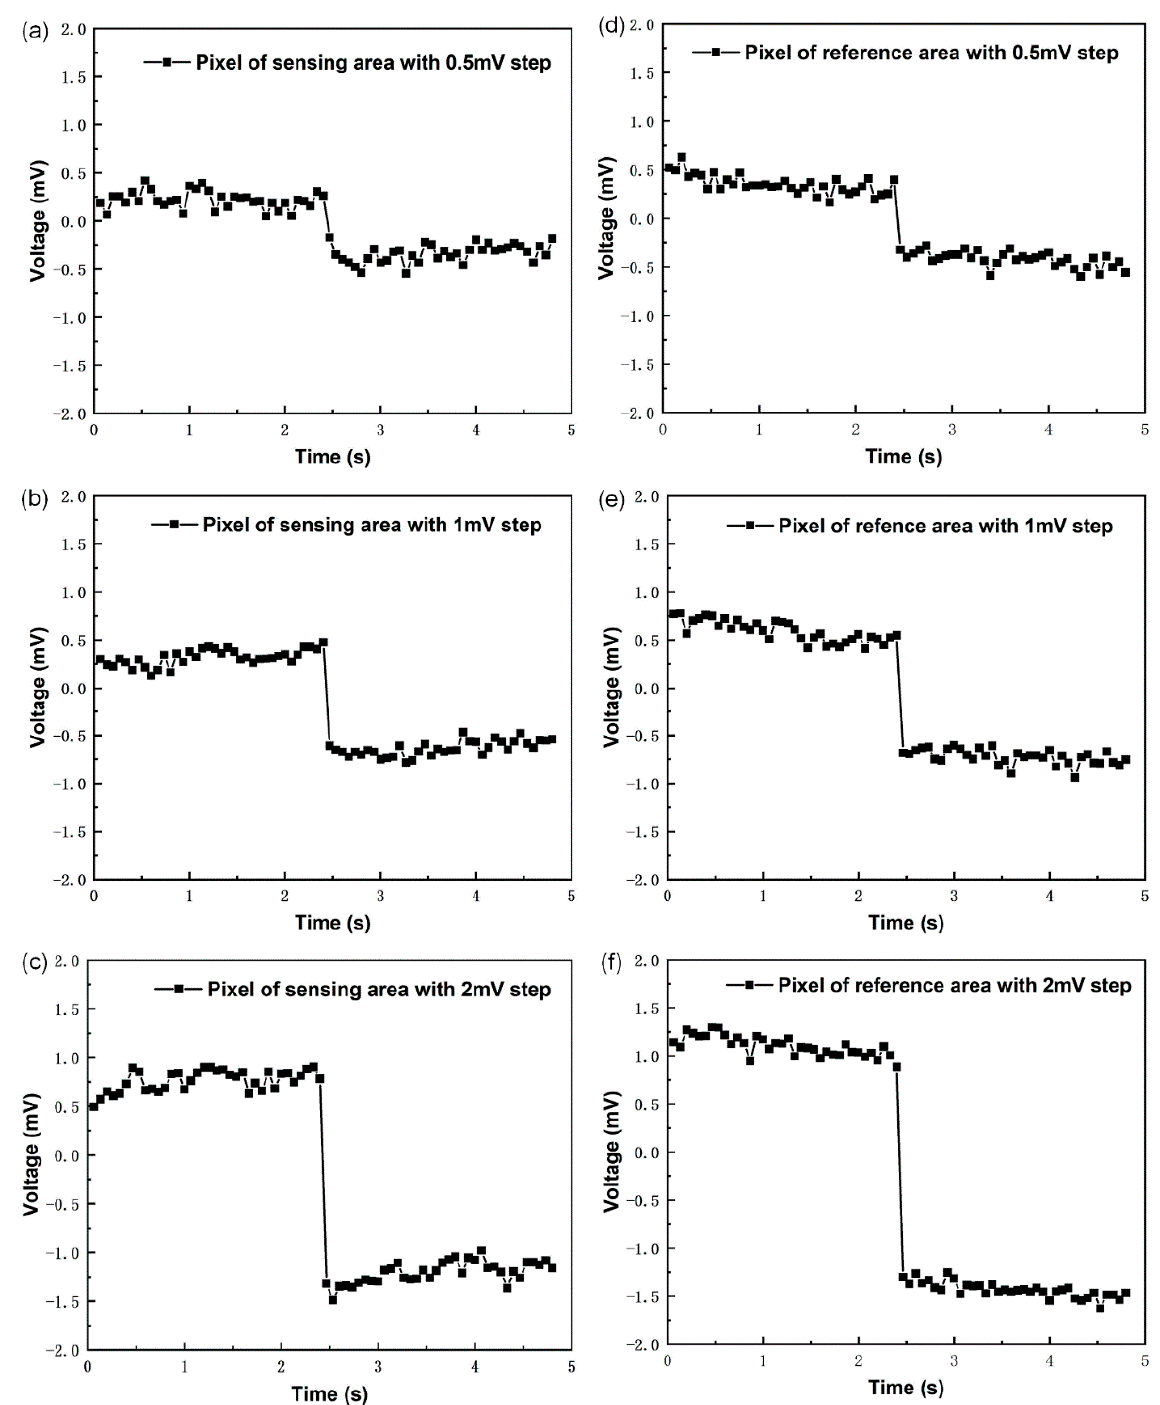
Figure 7. The change in the pixel output voltage with the reference voltage. ( a ) Pixel of the sensing area output at a 0.5 mV step input. ( b ) Pixel of the sensing area output at a 1 mV step input. ( c ) Pixel of the sensing area output at a 2 mV step input. ( d ) Pixel of the reference area output at a 0.5 mV step input. ( e ) Pixel of the reference area output at a 1 mV step input. ( f ) Pixel of the reference area output at a 2 mV step input.